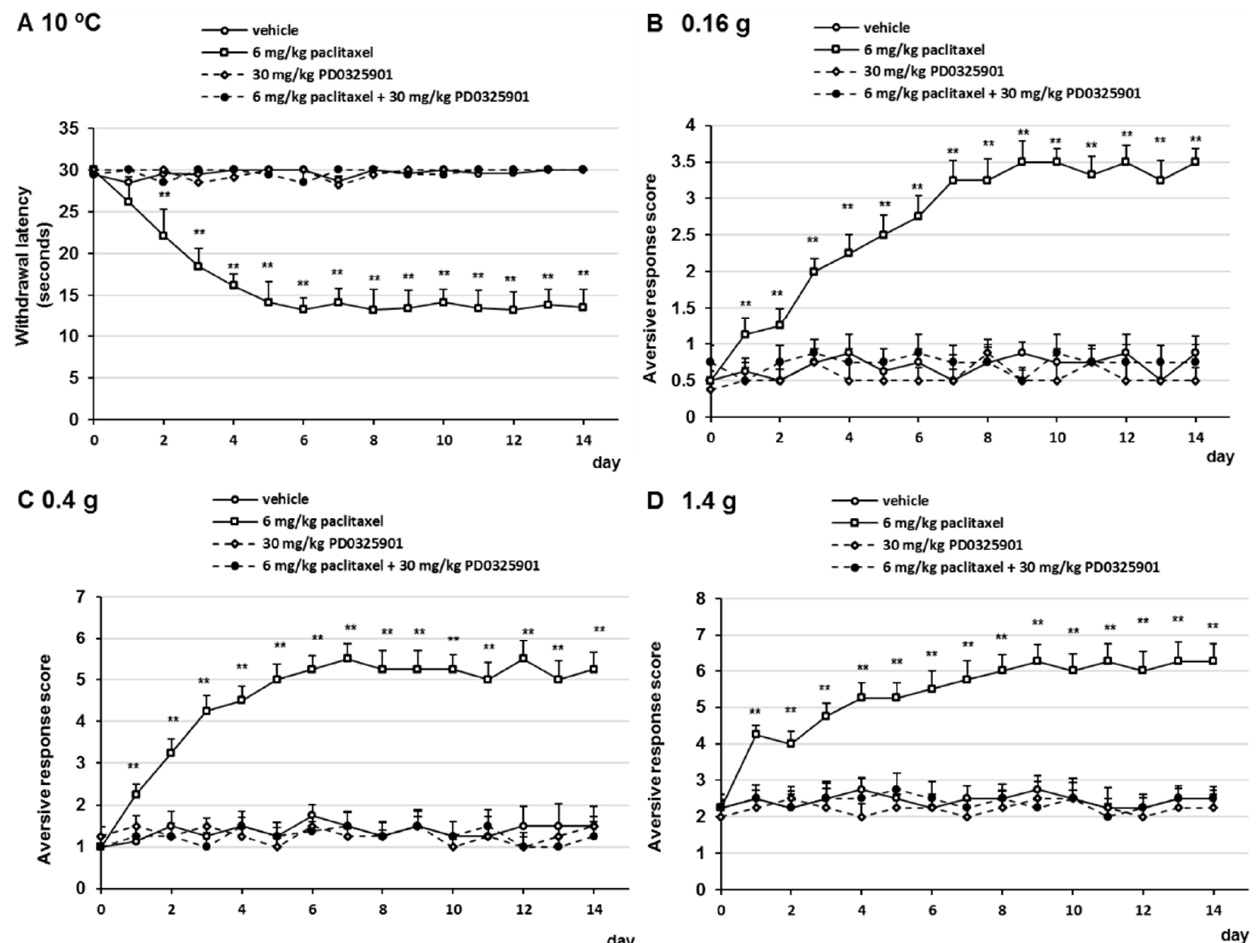
Figure 7. Inhibitory effect of PD0325901 on paclitaxel-induced cold and mechanical allodynia in mice. Paclitaxel (6 mg/kg, i.p.) was administered on days 0 and 7, and PD0325901 (30 mg/kg, p.o.) was administered daily from days 0 to 14. ( A ) Withdrawal latencies, presented as means ± standard deviations (S.D.), represent the time taken by mice to withdraw their hind paws following cold stimulation (10 °C) ( n = 7 per group). ** p < 0.01 vs. vehicles (Shapiro–Wilk test and Kruskal–Wallis test followed by the Scheffe test). ( B – D ) The number of paw lifts elicited by five mechanical stimulations using von Frey filaments corresponding to ( B ) innocuous (0.16 g), ( C ) intermediate (0.4 g), and ( D ) noxious (1.4 g) bending forces. The aversive response score was calculated based on two paw lifts ( n = 7 per group). ** p < 0.01 vs. vehicles (Shapiro-Wilk test and one-way analysis of variance (ANOVA) with Tukey test).